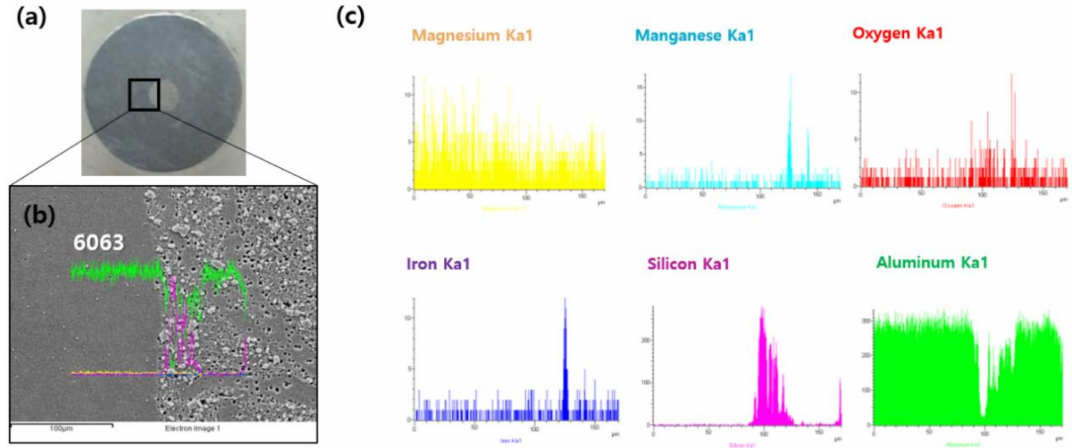
Figure 7. Elemental mapping of the area near the interface between Al6063 and Al3003. ( a ) Picture of a cross-section of the sample, ( b ) SEM image and mapping of all the elements, and ( c ) mapping of the major elements.